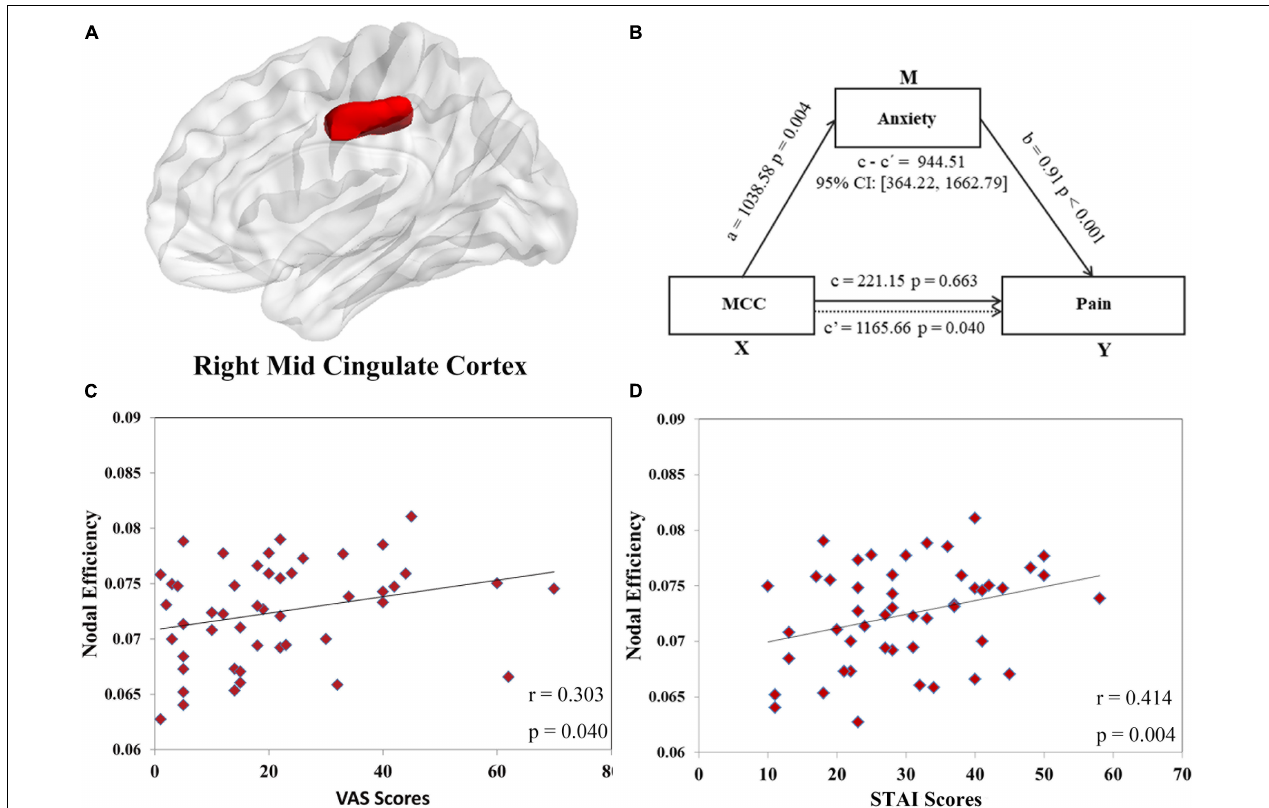
FIGURE 3 | The positive correlations between the nodal efficiency of the right midcingulate cortex (MCC, shown in panel (A) and the visual analog scale (VAS) scores ( r = 0.303, p = 0.040, shown in panel (C) and state anxiety inventory (SAI) scores ( r = 0.414, p = 0.004, shown in panel (D) were found in orthodontic pain group. In mediation analysis, illustration (B) demonstrates that the node efficiency of MCC affects pain through anxiety in subjects with orthodontic pain, with sex and age controlled in the